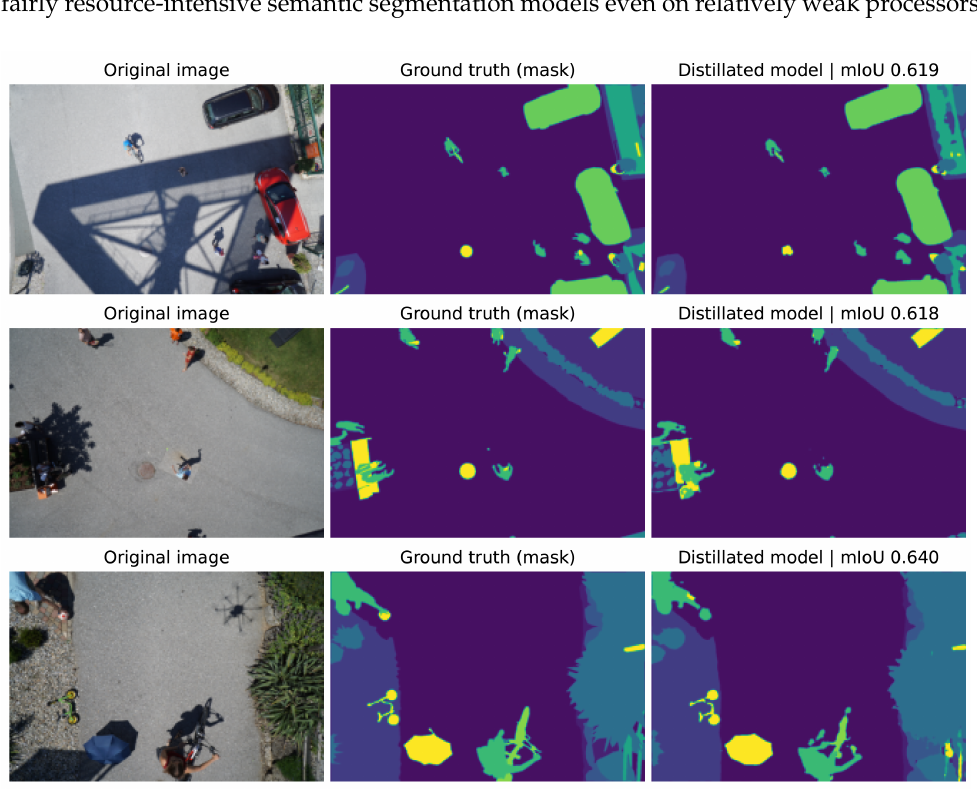
Figure 5. An example of the quality of a student’s network based on the PSPNet architecture with the MobileNetV2 encoder network after knowledge distillation. The first column of the figure shows the original images. The next shows the markup masks (reference markup of the corresponding image). The last column shows the results of the student’s network operation after knowledge